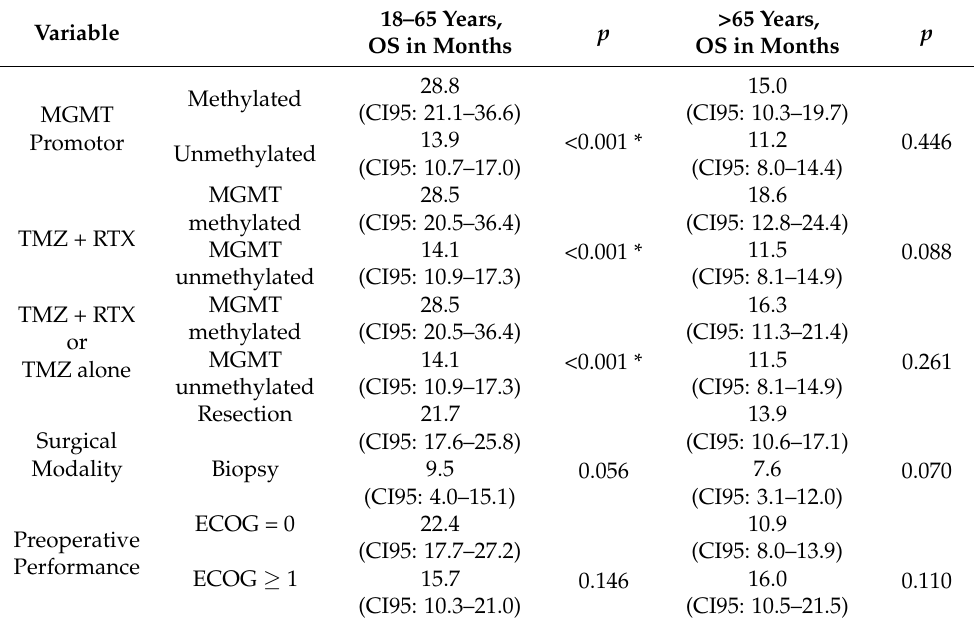
Table 2. Mean estimated PFS in comparison between older (more than 65 years) and younger patients (18 to 65 years) in relation to MGMT promotor methylation status, adjuvant therapy, surgical modality and preoperative